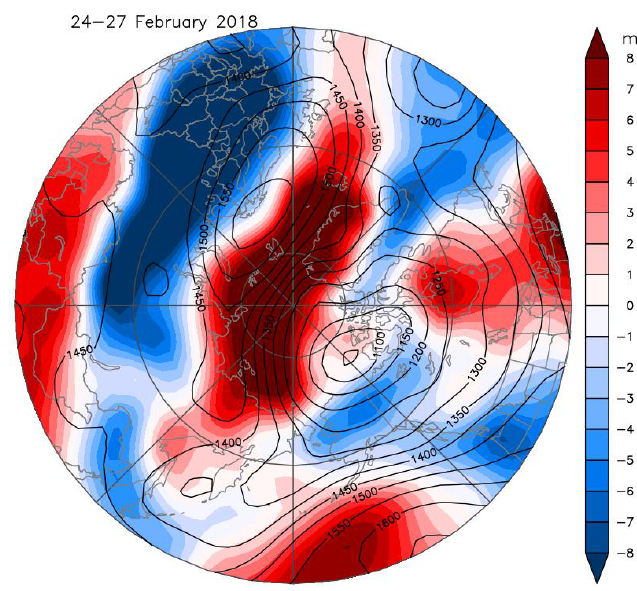
Figure 5. Composite of atmospheric 850 hPa geopotential height (contours in units of m) and temperature anomaly fields (color shading) for 24–27 February 2018. Data are from NCEP–NCAR reanalysis.